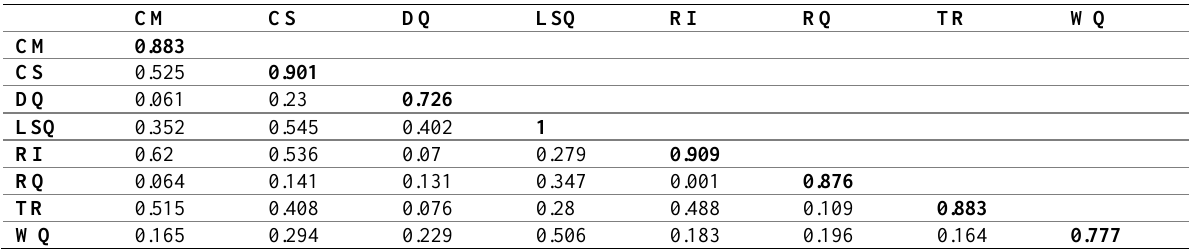
Table 3: Discriminant